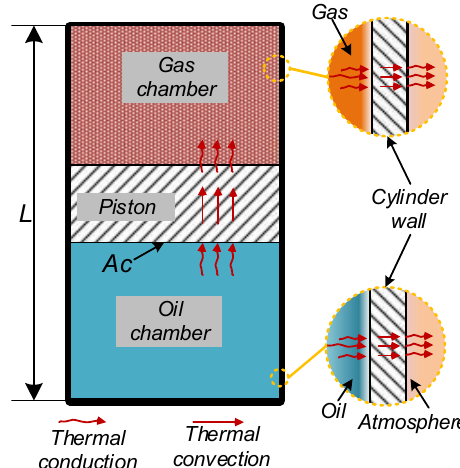
Figure 3. Thermodynamic process of the piston